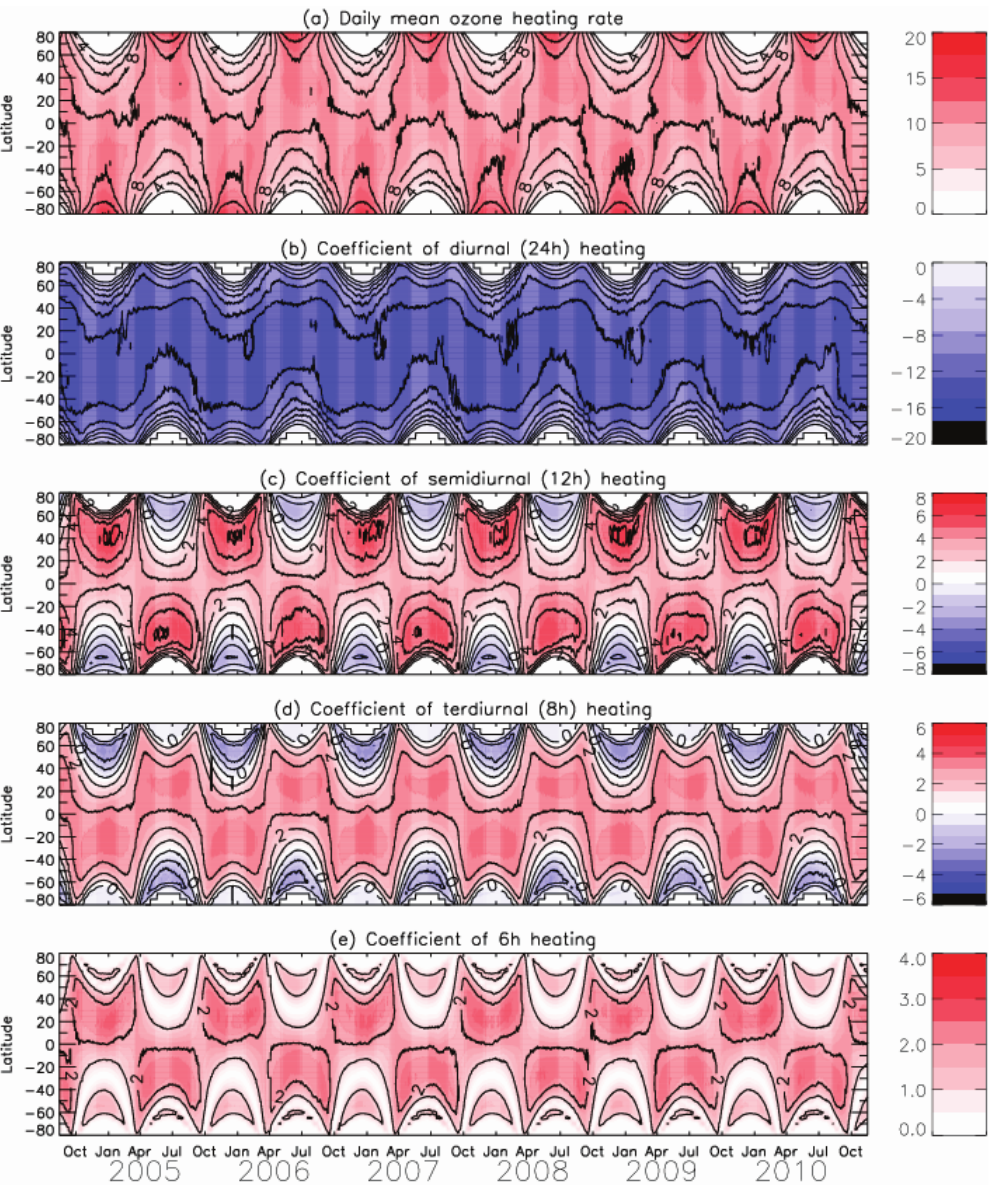
Fig. 3. Latitude-time sections of the daily mean (a) , diurnal (b) , semidiurnal (c) , terdiurnal (d) , and 6-h (e) components of the ozone heating rate over the period from August 2004 to November 2010 at 50km. For the tidal components of ozone heating, positive means the phase is at 00:00LT; negative means the phase is at 12:00LT for diurnal (b) , 06:00LT for semidiurnal (c) , 04:00LT for terdiurnal (d) , and 03:00LT for 6-h (e)